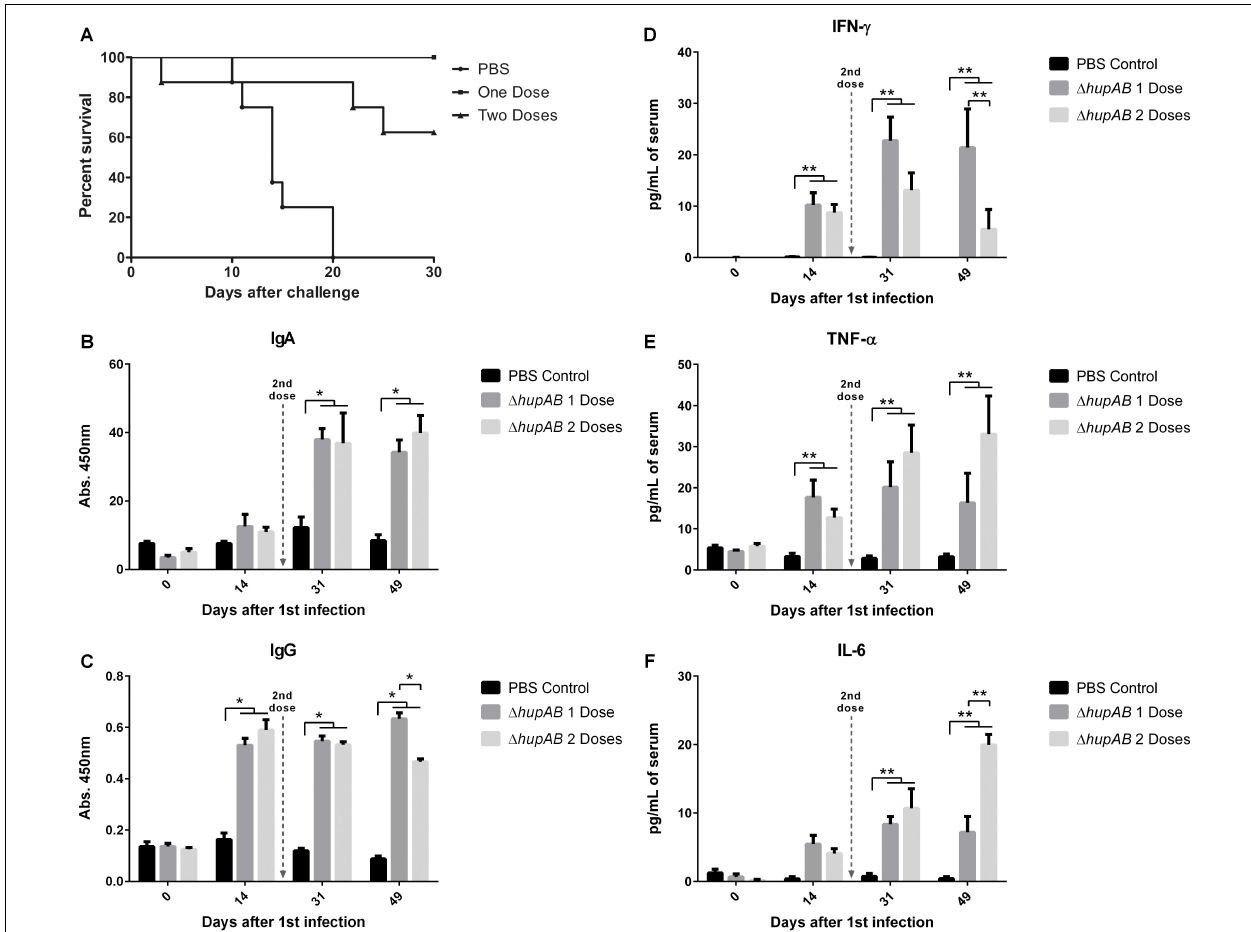
FIGURE 3 | Protection assay, antibody production, and cytokine detection after immunization. BALB/c mice were orally immunized with one (on day 0) or two (on days 0 and 21) doses of 2 × 10 9 CFU of PT4 (cid:49) hupAB or inoculated with PBS (control). (A) Mice were orally challenged with 1 × 10 7 CFU of the wild-type strain SEnPT4 21 days after the last immunization. The graph shows the percentage of immunized animals that survived the challenge. Fecal and serum samples were obtained on days 0, 14, 31, and 49 after the first immunization to measure specific IgA (B) and total IgG (C) by ELISA, respectively. SEnPT4 antigens were used as the coating antigen (1 µ g/mL). Results are expressed as the mean ± SEM of OD 450 nm values of seven mice per group and are a representative experiment of two assays. ∗ P < 0.01 compared to the control group with Bonferroni’s test. Cytokine detection in serum collected from groups of nine BALB/c mice after immunization with one (on day 0) or two (on days 0 and 21) doses of 2 × 10 9 CFU of PT4 (cid:49) hupAB or with PBS (control). Serum samples were obtained on days 0, 14, 31, and 49 after the first immunization, and levels of IFN- γ (D) , TNF- α (E) and IL-6 (F) were measured by Cytokine Bead Array. Results are expressed as the mean ± SEM of serum concentration (pg/mL). ∗∗ P < 0.05 compared to the control group with Tukey’s